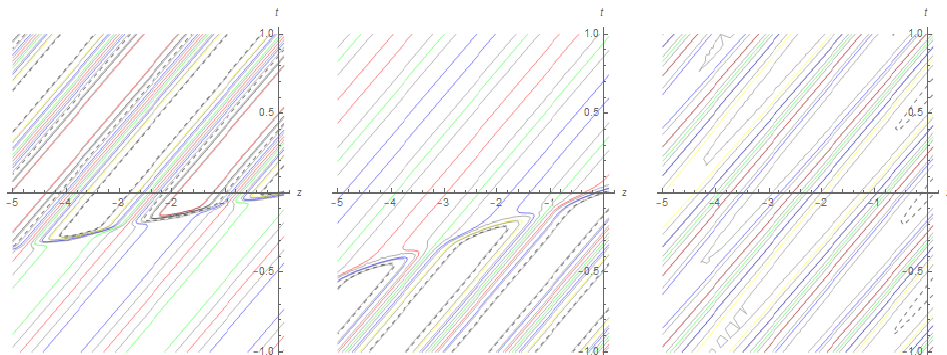
Figure 24. Contour profiles for Figure 23.